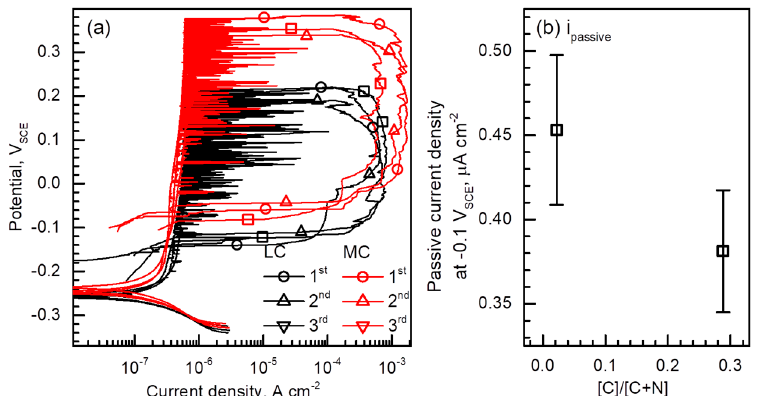
Figure 11. ( a ) Cyclic potentiodynamic polarization curves of the LC and MC samples measured in a 3.5 wt% NaCl solution at 25 °C with a potential sweep rate of 0.167 mV s − 1 (integration of Figure 8a,b). ( b ) Average i passive measured at − 0.1 V SCE from the polarization curves.